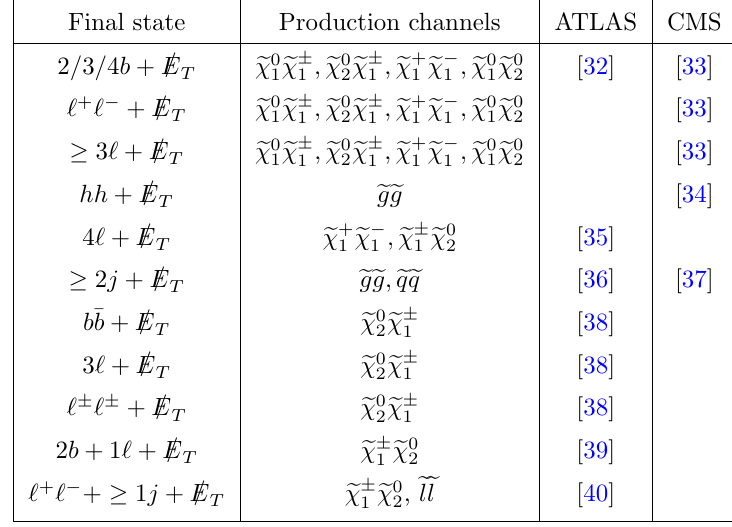
Table 2 . List of the experimental searches from LHC for higgsinos as relevant for our current study with G e